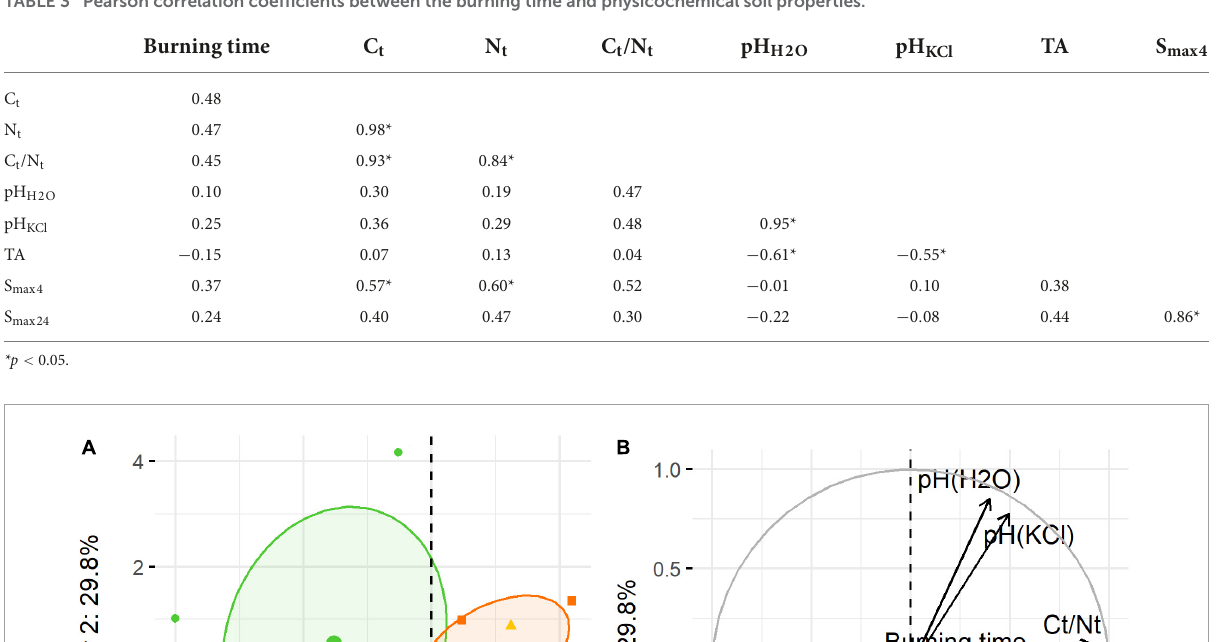
TABLE 3 Pearson correlation coefficients between the burning time and physicochemical soil properties.